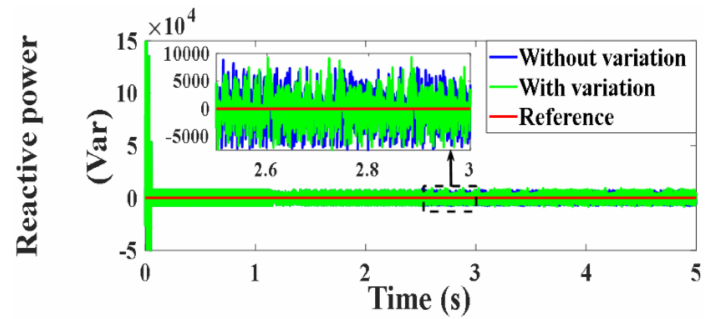
Figure 74. Reactive power under PVC